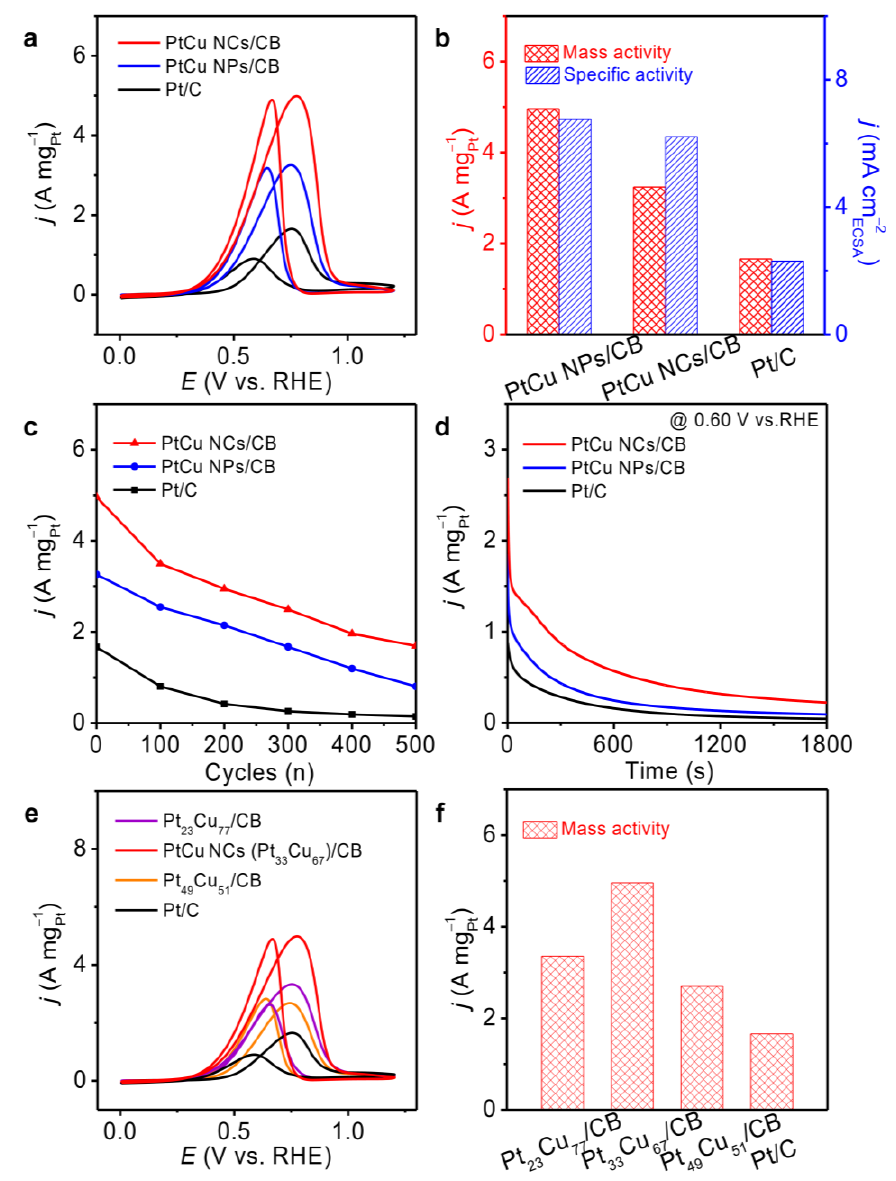
Figure 4. EOR performances of the Pt-based catalysts. ( a ) Pt mass-normalized CV curves of the EOR on PtCu NCs/CB, PtCu NPs/CB, and Pt/C in the mixed electrolyte of 1.0 M KOH and 1.0 M C 2 H 5 OH. ( b ) Mass activity and specific activity of PtCu NCs/CB, PtCu NPs/CB, and Pt/C. ( c ) The cycling stability measurements of PtCu NCs/CB, PtCu NPs/CB, and Pt/C. ( d ) The chronoamperometry curves of PtCu NCs/CB, PtCu NPs/CB, and Pt/C at 0.6 V vs. RHE for 1800 s. ( e ) Pt mass-normalized CV curves of the EOR on Pt 23 Cu 77 /CB, PtCu NCs (Pt 33 Cu 67 )/CB, Pt 49 Cu 51 /CB, and Pt/C. ( f ) Mass activity of Pt 23 Cu 77 /CB, PtCu NCs (Pt 33 Cu 67 )/CB, Pt 49 Cu 51 /CB, and Pt/C.